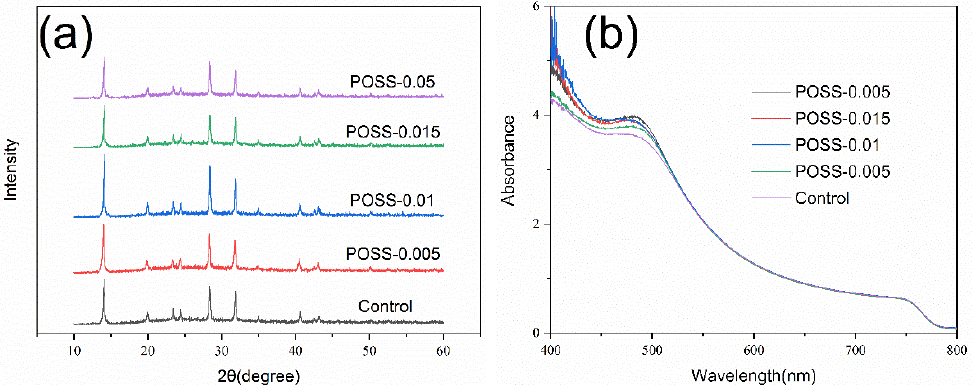
Figure 2. ( a ) XRD patterns and ( b ) UV–Vis absorption spectra of the MAPbI3 layers over the fluorine-doped tin oxide (FTO)/NiO X /POSS with various POSS contents.